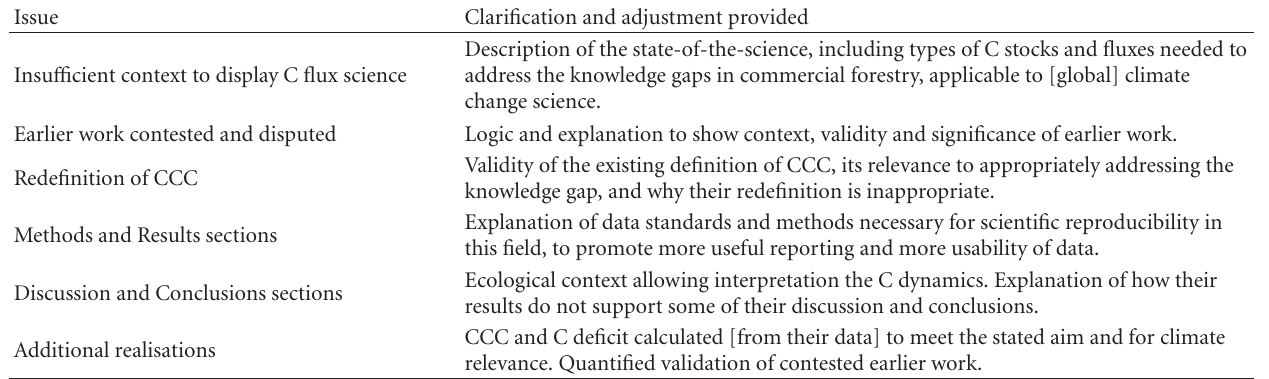
Table 1: Summary of issues in Moroni et al. [1] addressed in this